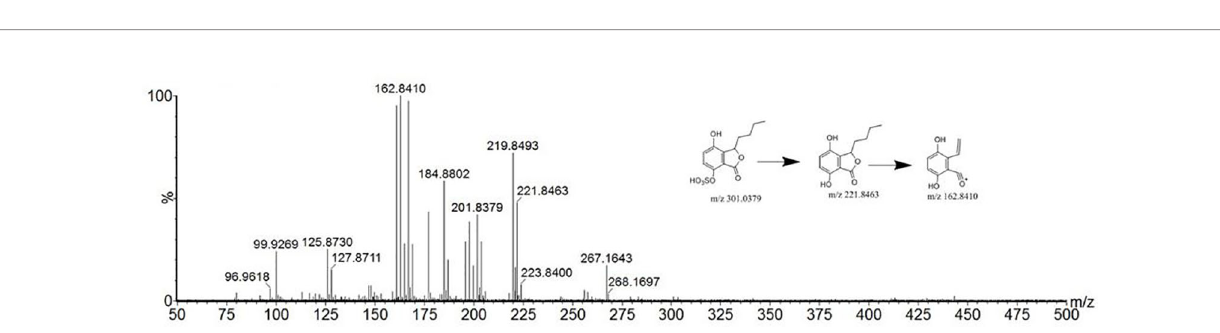
FIGURE 5 | Tandem mass spectra and possible fragment pathways of 4-hydroxy-3-butyl-benzoquinone in positive ion mode.